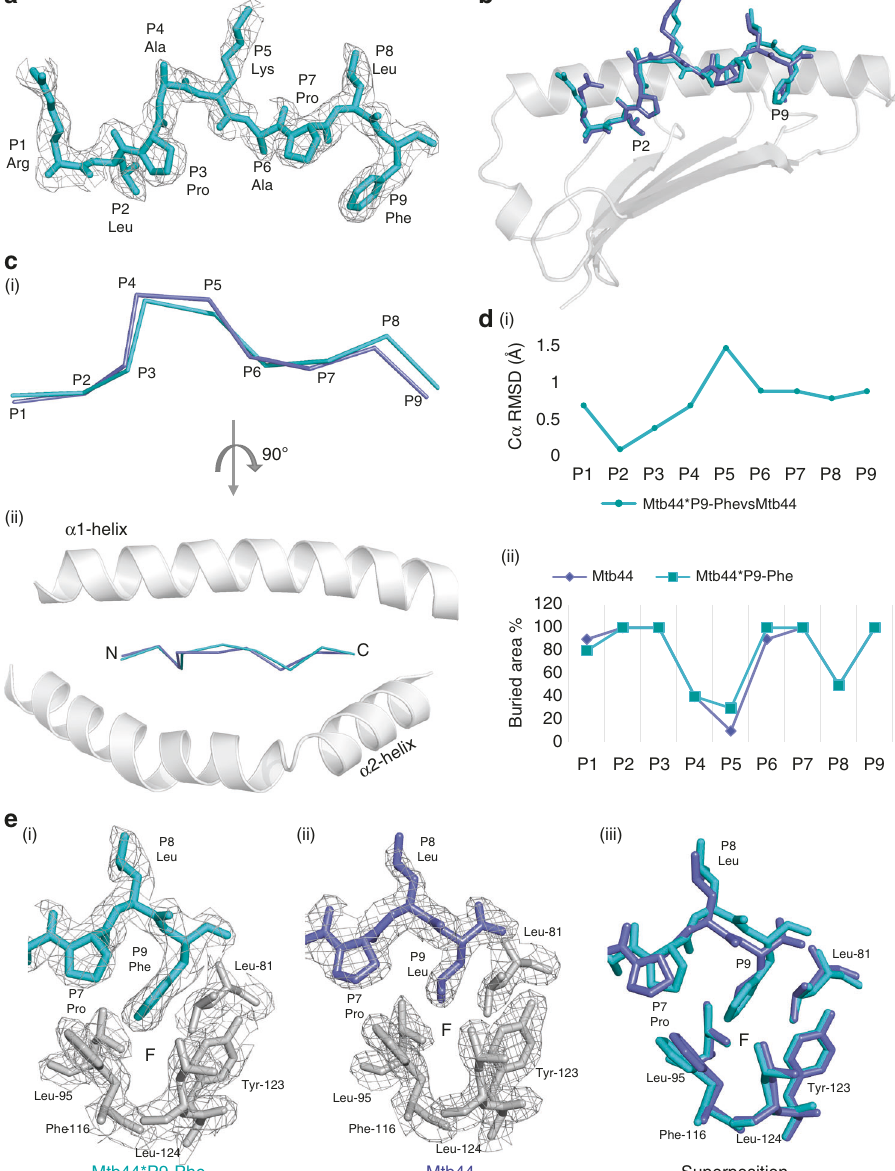
Fig. 4 Structural analyses of the Mtb44 position 9 peptide variant: Mtb44*P9-Phe. a The Mtb44 position 9 phenylalanine variant Mtb44*P9-Phe (blue- cyan) visualised side-on with electron density overlaid in grey mesh and HLA-E*01:03 HC + β 2M omitted for clarity. b Superposition of Mtb44*P9-Phe (blue-cyan) and Mtb44 (purple-slate) peptides depicted as sticks with the binding groove α 1 helix and β -sheet fl oor depicted in grey cartoon. c C α backbone alignment of Mtb44*P9-Phe (blue-cyan) and Mtb44 (purple-slate) peptides visualised side-on ( i ) and from above ( ii ), with binding groove α 1 + 2 helices depicted as grey cartoon. d ( i ) Distance in Å between superposed C α atoms of Mtb44*P9-Phe versus Mtb44 with peptide residue position on the x axis and distance (Å) on the y axis. ( ii ) Buried residue area percentage for Mtb44*P9-Phe (blue-cyan) and Mtb44 (purple-slate) peptides with residue position along the x axis and buried area % on the y axis. e F pocket visualisation of ( i ) Mtb44*P9-Phe ( ii ) Mtb44 and ( iii ) Mtb44*P9-Phe/ Mtb44 superposed complexes. HLA-E*01:03 HC-derived F pocket-forming residues depicted as grey sticks with electron density overlaid as grey